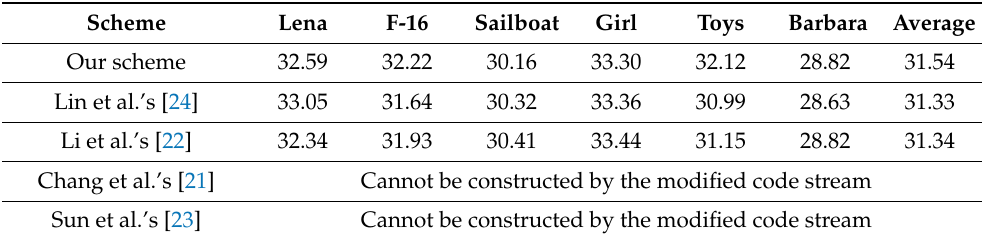
Table 2. Comparative performance of PSNR (dB) for six test images between our method and other methods base on